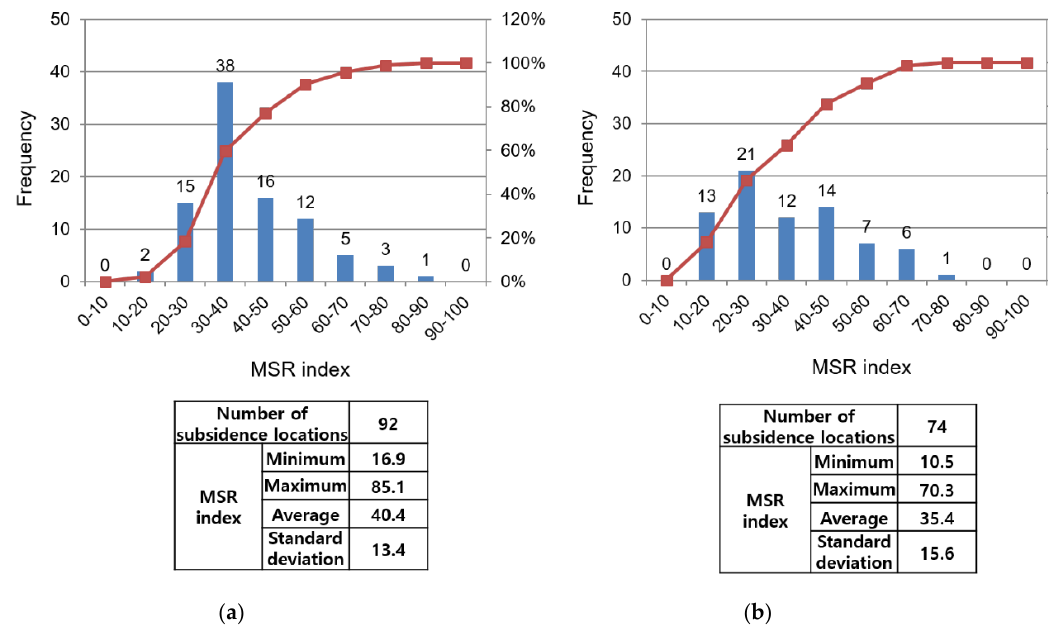
Figure 15. Range of MSR index: ( a ) coal mines ( b ) other types of mines.